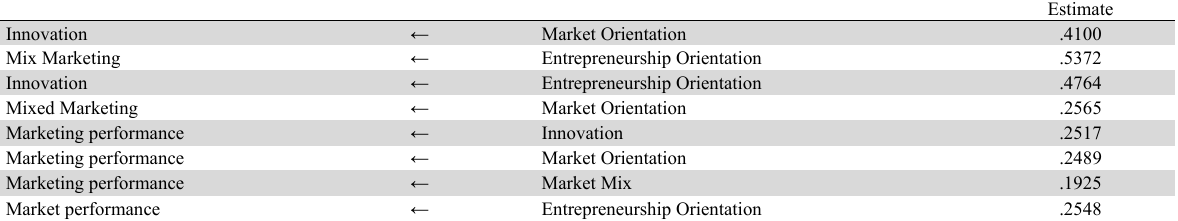
Results of Standardized Regression Weights